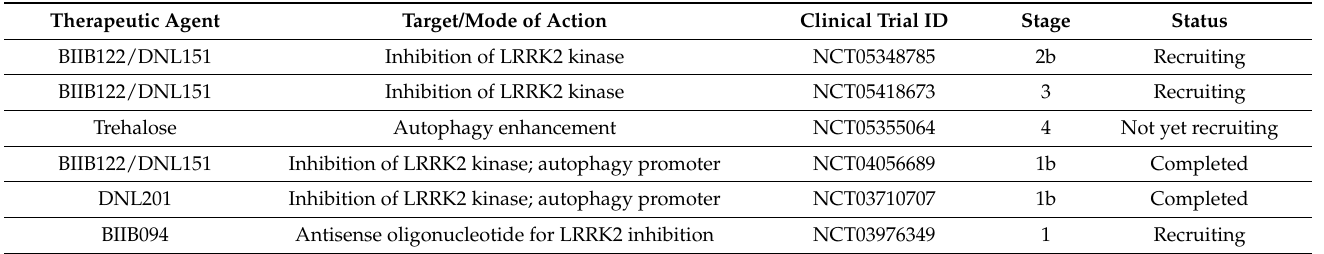
Table 3. Clinical trials of therapeutic interventions in LRRK2-PD